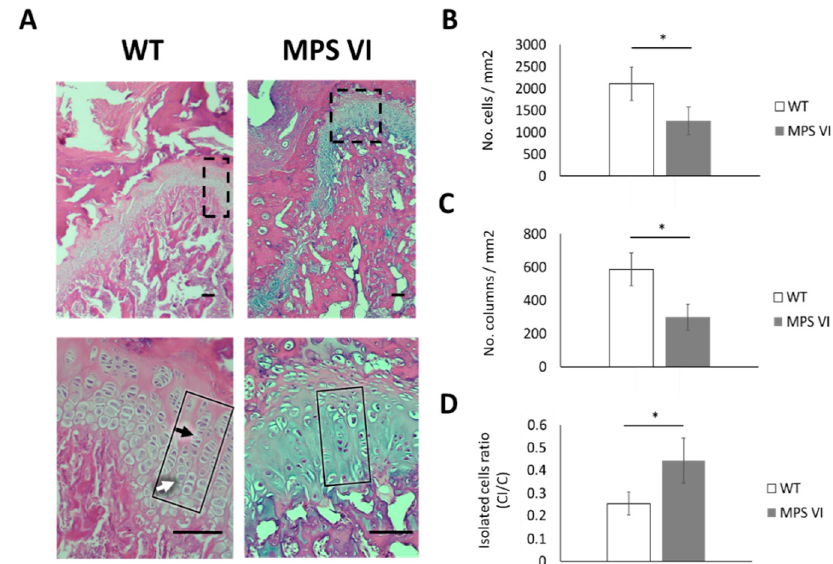
Figure 6. Histological characteristics of growth plates from 3-month-old WT and MPS VI rats. ( A ) The upper shows low magnification images (4×), showing no remarkable differences among WT and MPS samples. In the lower panel, higher magnification (20 v) images (corresponding to the areas highlighted in dotted lines in the upper panel) show that in the normal growth plates chondrocytes are arranged in organized columns (black rectangle) and it is possible to differentiate proliferative (black arrow) from hypertrophic (white arrow). This architecture is lost in the mucopolysaccharidoses (MPS) rats (black rectangle). Histological sections were stained with hematoxylin and eosin. Scale bars = 100 µm; ( B – D ) Results correspond to whole growth plate findings due to loss of zonal arrangement (see text). ( B ) Cell density; ( C ) Column density (CD); ( D ) Results for the isolated cells ratio (CI/C). Open and black bars correspond to wild type (WT) and MPS VI rats, respectively. Results are reported per growth plate zone as follows: proliferative (PZ), pre-hypertrophic (pre-HZ), and hypertrophic (HZ) zones ( n = 3 per group). The symbol (*) indicates a statistically significant difference ( p < 0.05).